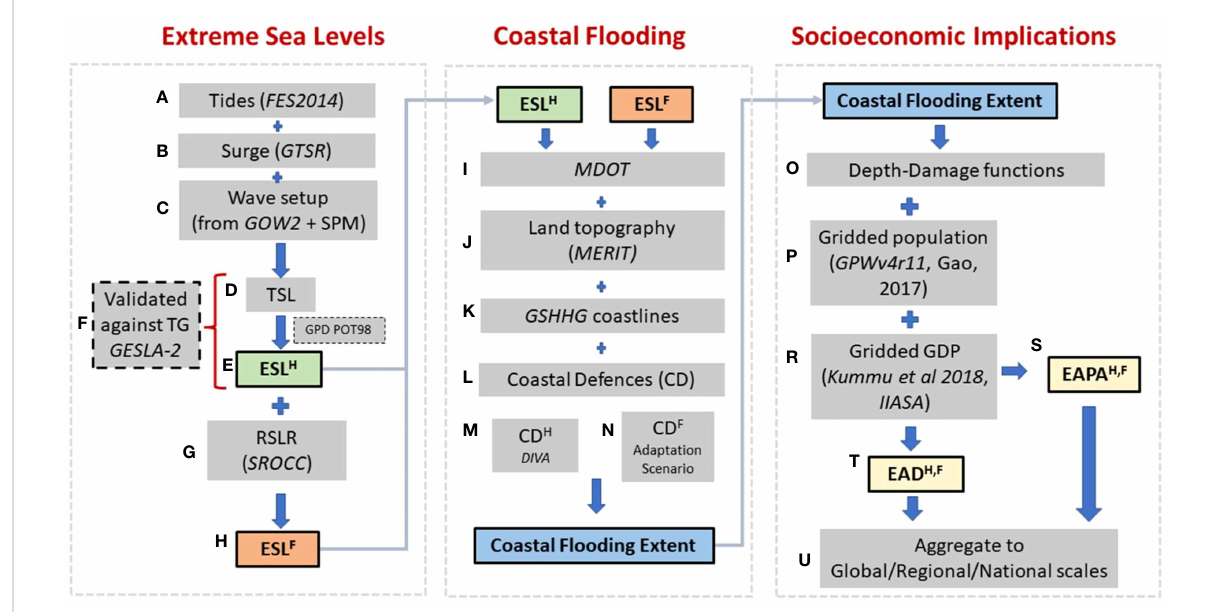
FIGURE 1 Diagrammatic representation of the processes used in the determination of the Socioeconomic Impacts of projected extreme coastal fl ooding. As explained in the Materials and Methods section, the full analysis involves a large number of sequential steps, divided into three broad areas. Initially, Extreme Sea Levels (ESL) are determined for a variety of probabilities of exceedance at coastal segments (DIVA) around the world. These are determined both for the historical period (superscript H) and future periods (superscript F). These values of ESL are then used to determine the extent of Coastal Flooding, accounting for existing and future Coastal Defences (CD). Finally, we sum over all exceedance probabilities to determine the Expected Annual People Affected ( EAPA ) and Expected Annual Damage ( EAD ). The analysis uses numerous global datasets (shown in italics). Terms and abbreviations are de fi ned in “ Materials and Methods ” section, where each step is referred to an element in the fi gure de fi ned by the alphabetical reference (A – U)